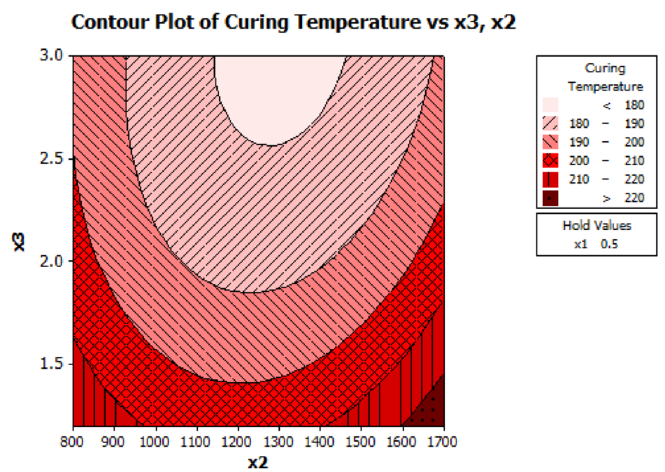
Figure 12 . Contour plot for lignin M w (X 2 ) and F/P (X 3 ) on curing temperatures of BPF resoles at 50% substitution of phenol with lignin.